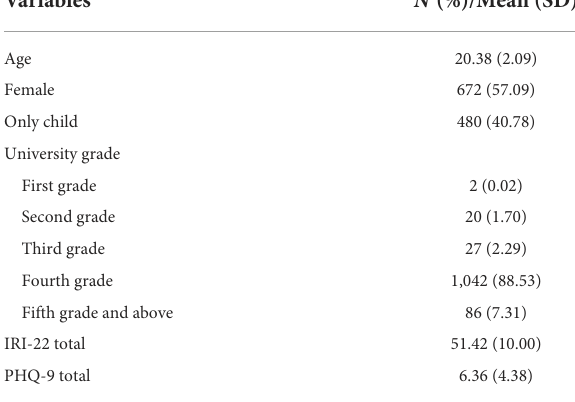
TABLE 1 Sample characteristics ( n = 1,177).